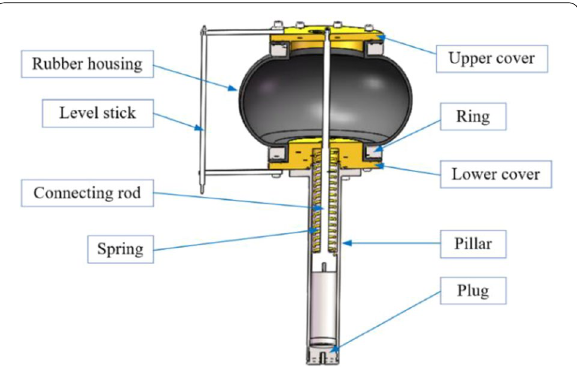
Figure 1 Composition of the reservoir